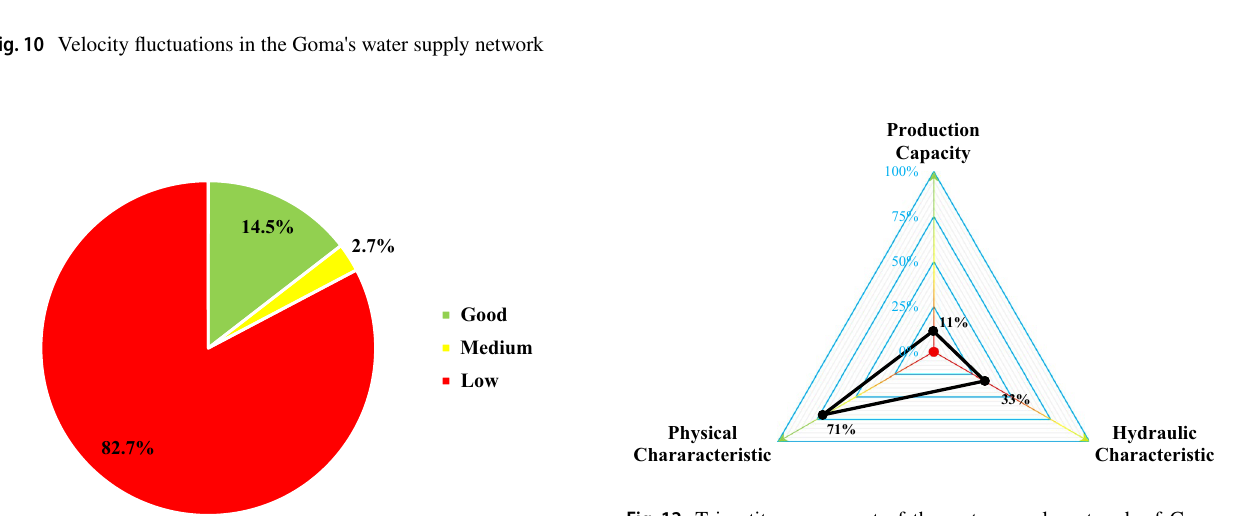
Fig. 12 Tripartite assessment of the water supply network of Goma